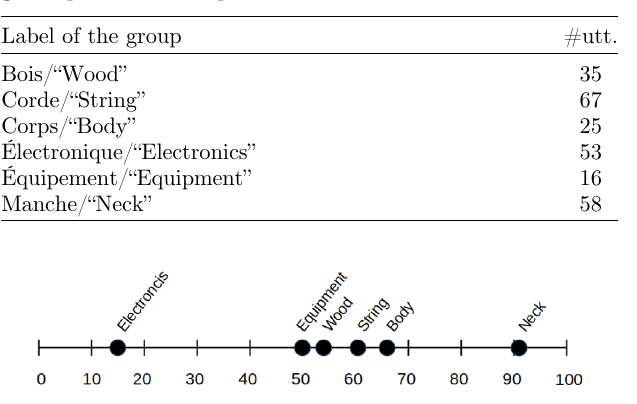
Figure 2. Percentage of utterances in relationship with the sense of touch by guitar parts